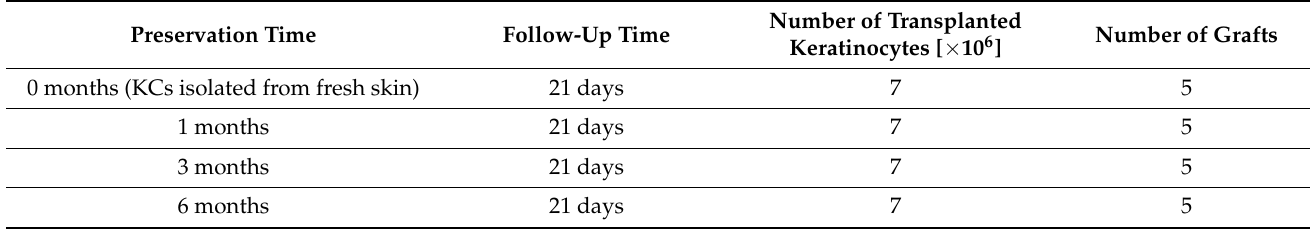
Table 2. Experimental groups—keratinocytes isolated from fresh or preserved skin and transplanted. Preservation Time Follow-Up Time